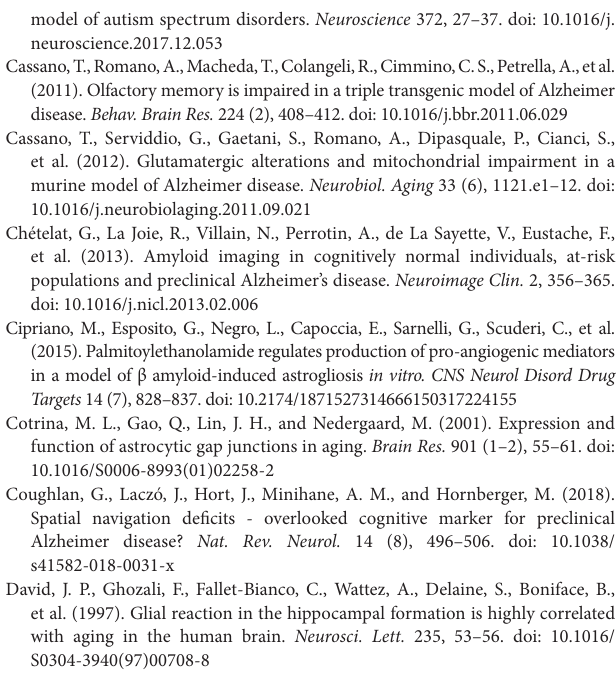
FIGURE S1 | Effects of aging on A β (1-42) production and tau protein phosphorylation in hippocampus of 3×Tg-AD and Non-Tg mice. (A) Representative Western blots for A β (1-42) and p[Ser396]tau and (B , C) densitometric analyses normalized to β -actin as loading control. Results are expressed as means ± SEM of percentage of controls (6-month-old/Non-Tg) (N = 3, in triplicate). Statistical analysis was performed by two-way ANOVA followed by Bonferroni’s post hoc test (** p < 0.01; *** p <